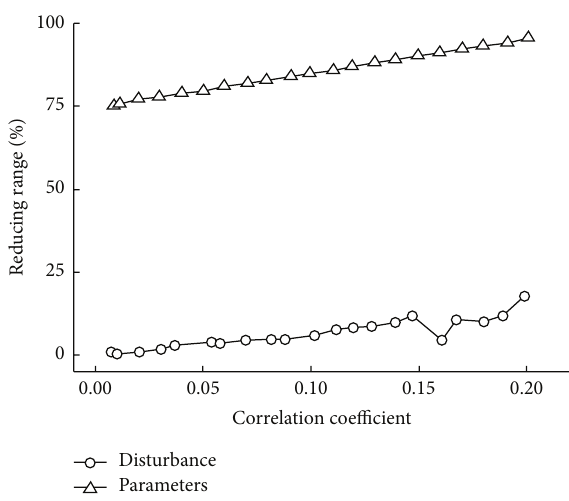
Figure 4: Optimization range of the correlation coefficient charac- teristic curve.